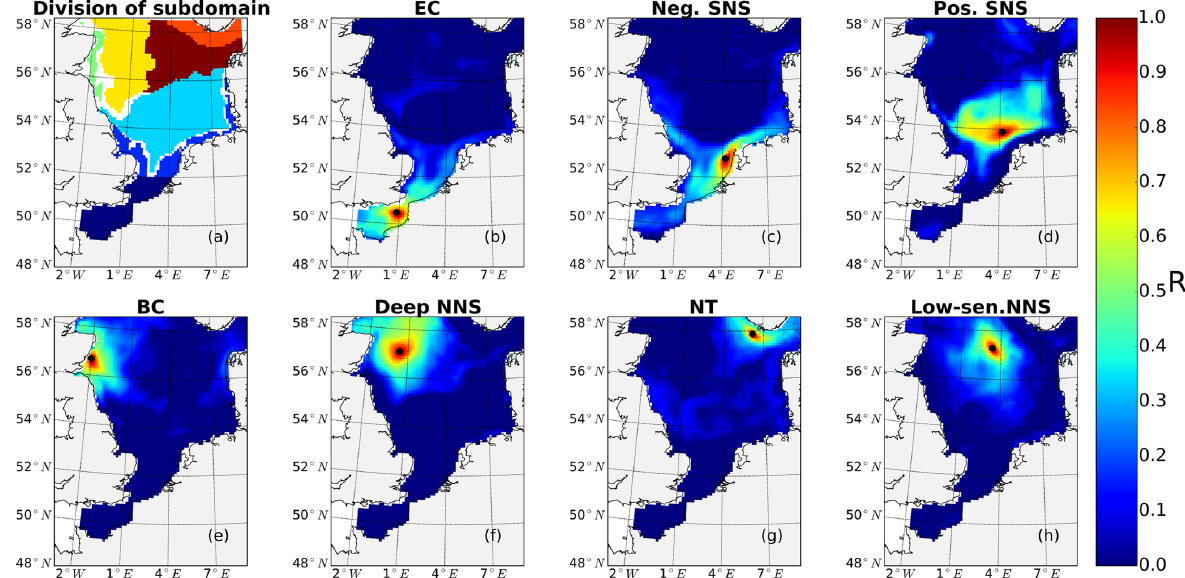
Figure A1. Subdomain divisions (a) , correlation coefficient of NPP variations at the most representative grid cell (black dot) and NPP variations in the surrounding grid cells for the English Channel (b) , negatively responding area in the southern North Sea (c) , positively responding area in the southern North Sea (d) , the eastern British coast (e) , the deeper part of northern North Sea (f) , the Norwegian Trench (g) and the low-sensitivity area in the northern North Sea (h) .